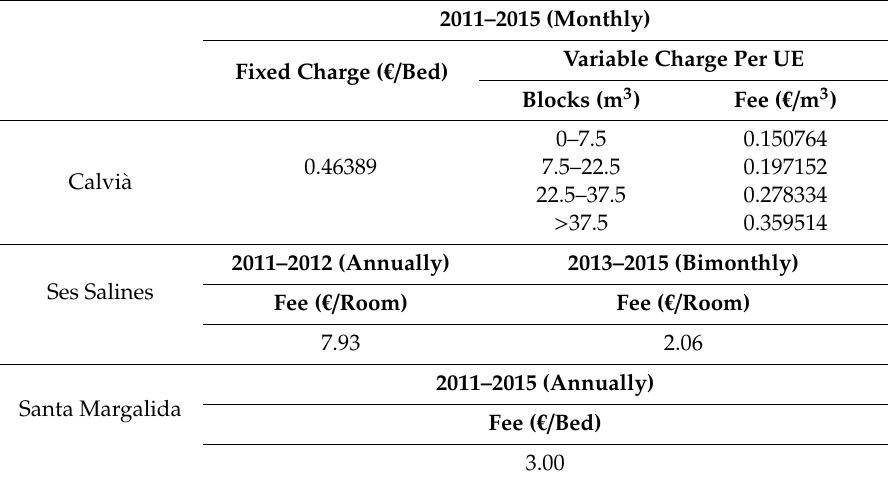
Table 2. Sewage tari ff per municipality and